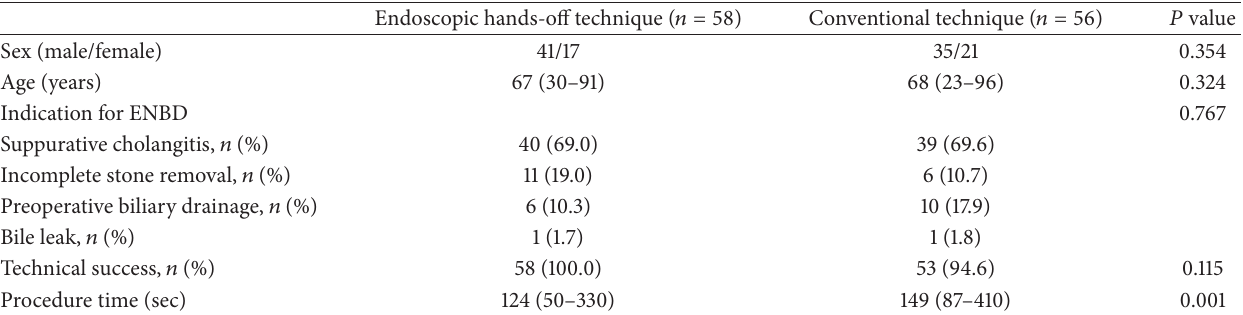
Table 1: Baseline characteristics and clinical outcomes of the